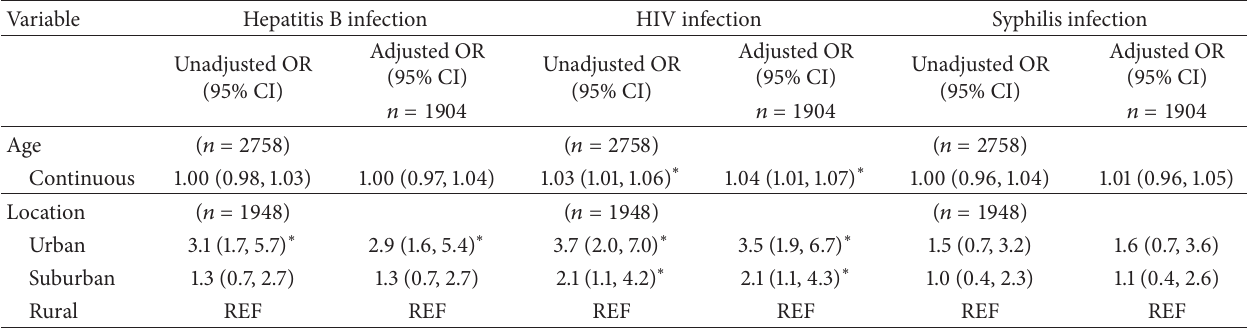
∗ Indicating statistical significance. REF: